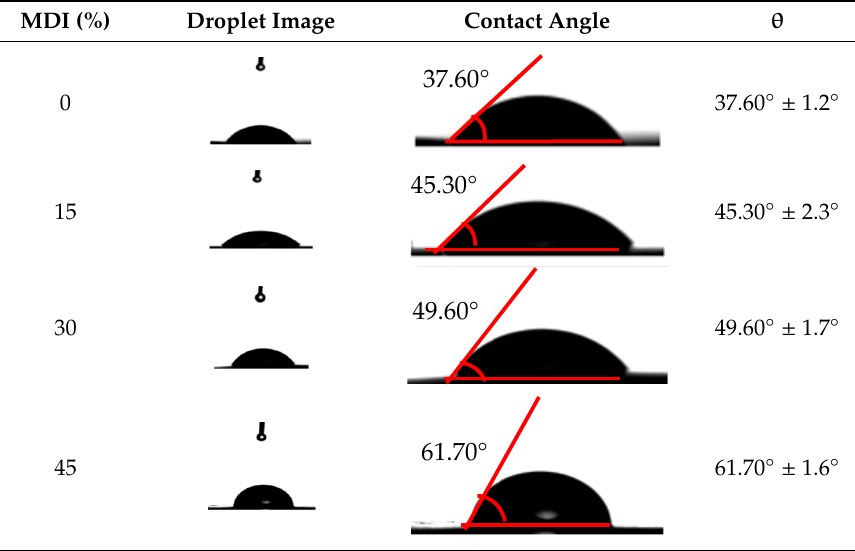
Table 2. Contact angle measurement of the cellulose acetate (CA) and cellulose acetate–polyurethane (CA–PU) films.